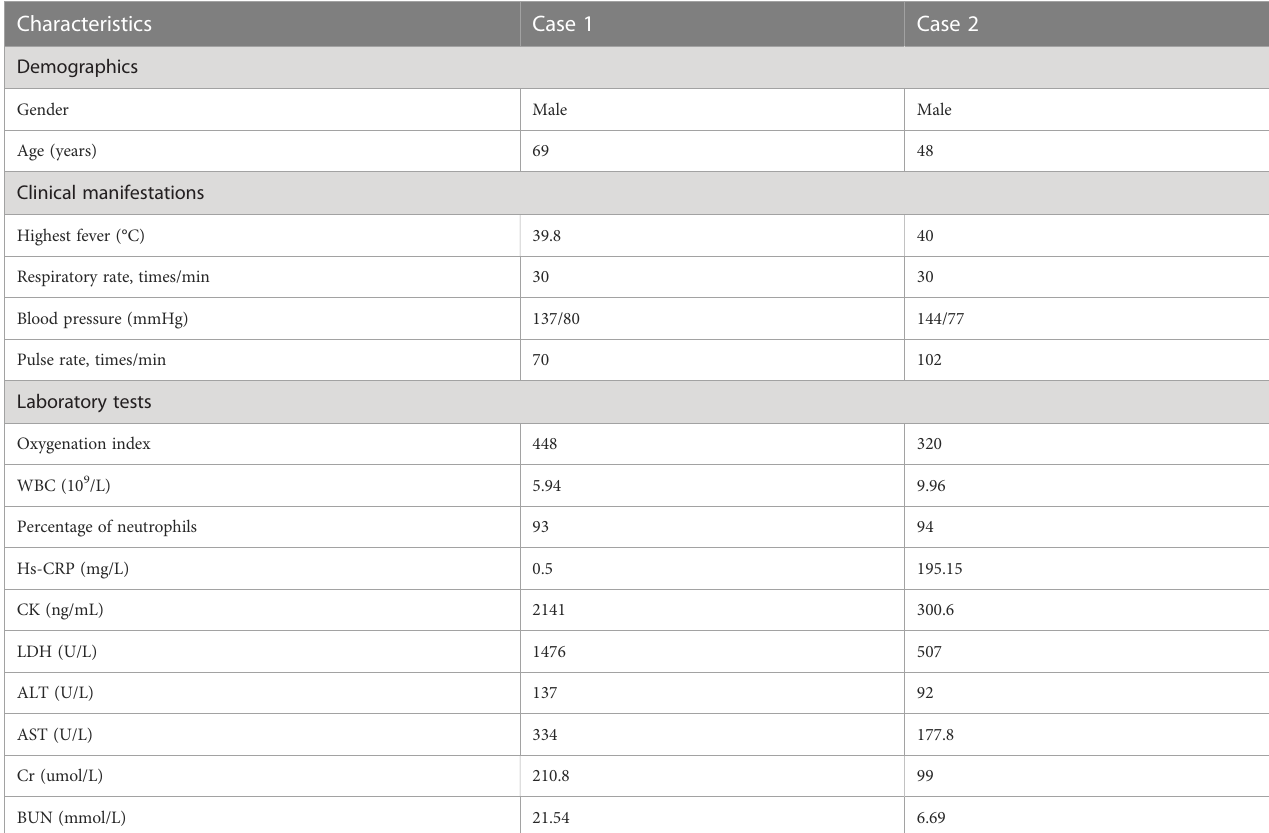
TABLE 1 Clinical features and laboratory indicators of two patients with C. psittaci pneumonia on admission. Characteristics